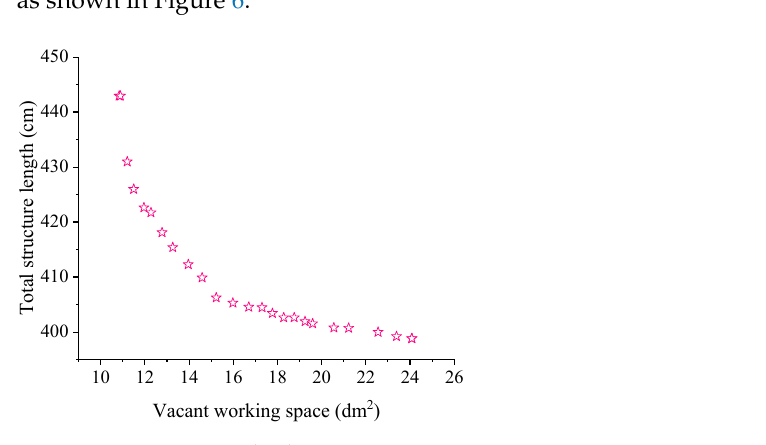
Figure 6. Pareto optimal solution set.